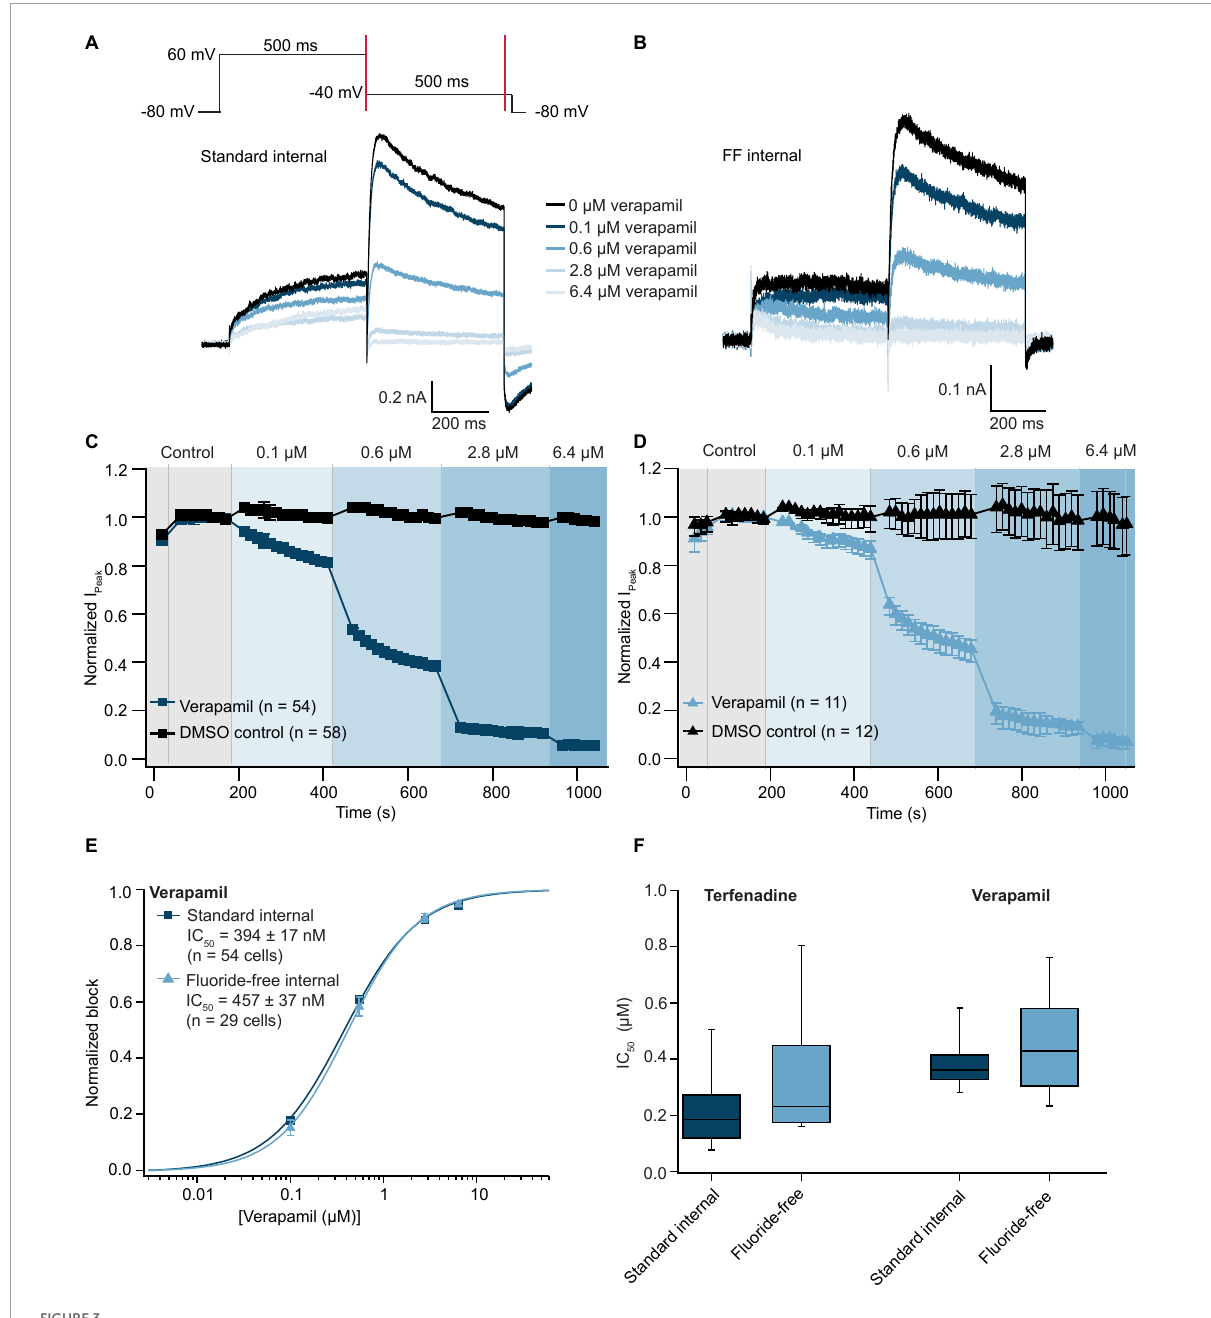
FIGURE3 Pharmacology of hERG recorded in standard and fluoride-free internal solution. (A,B) Raw current traces from an example HEK cell expressing hERG recorded in standard internal (A) and fluoride-free internal (B) solution was blocked by increasing concentrations of verapamil [voltage protocol is shown at the top of panel (A) ]. (C) Corresponding time course of block by verapamil in standard internal (C) and fluoride-free internal (D) , 54 or 11 cells, respectively. Time course of 58/12 cells in DMSO control is also shown within panels (C,D) . (E) Concentration response curve for verapamil in standard internal solution or fluoride-free solution are shown overlaid. (F) IC 50 s for terfenadine and verapamil recorded using standard internal or fluoride-free internal solution are shown as a box plot. The IC 50 s for verapamil and terfenadine recorded in standard internal or fluoride-free internal solution were not significantly different using a Student’s t -test ( P > 0.05).